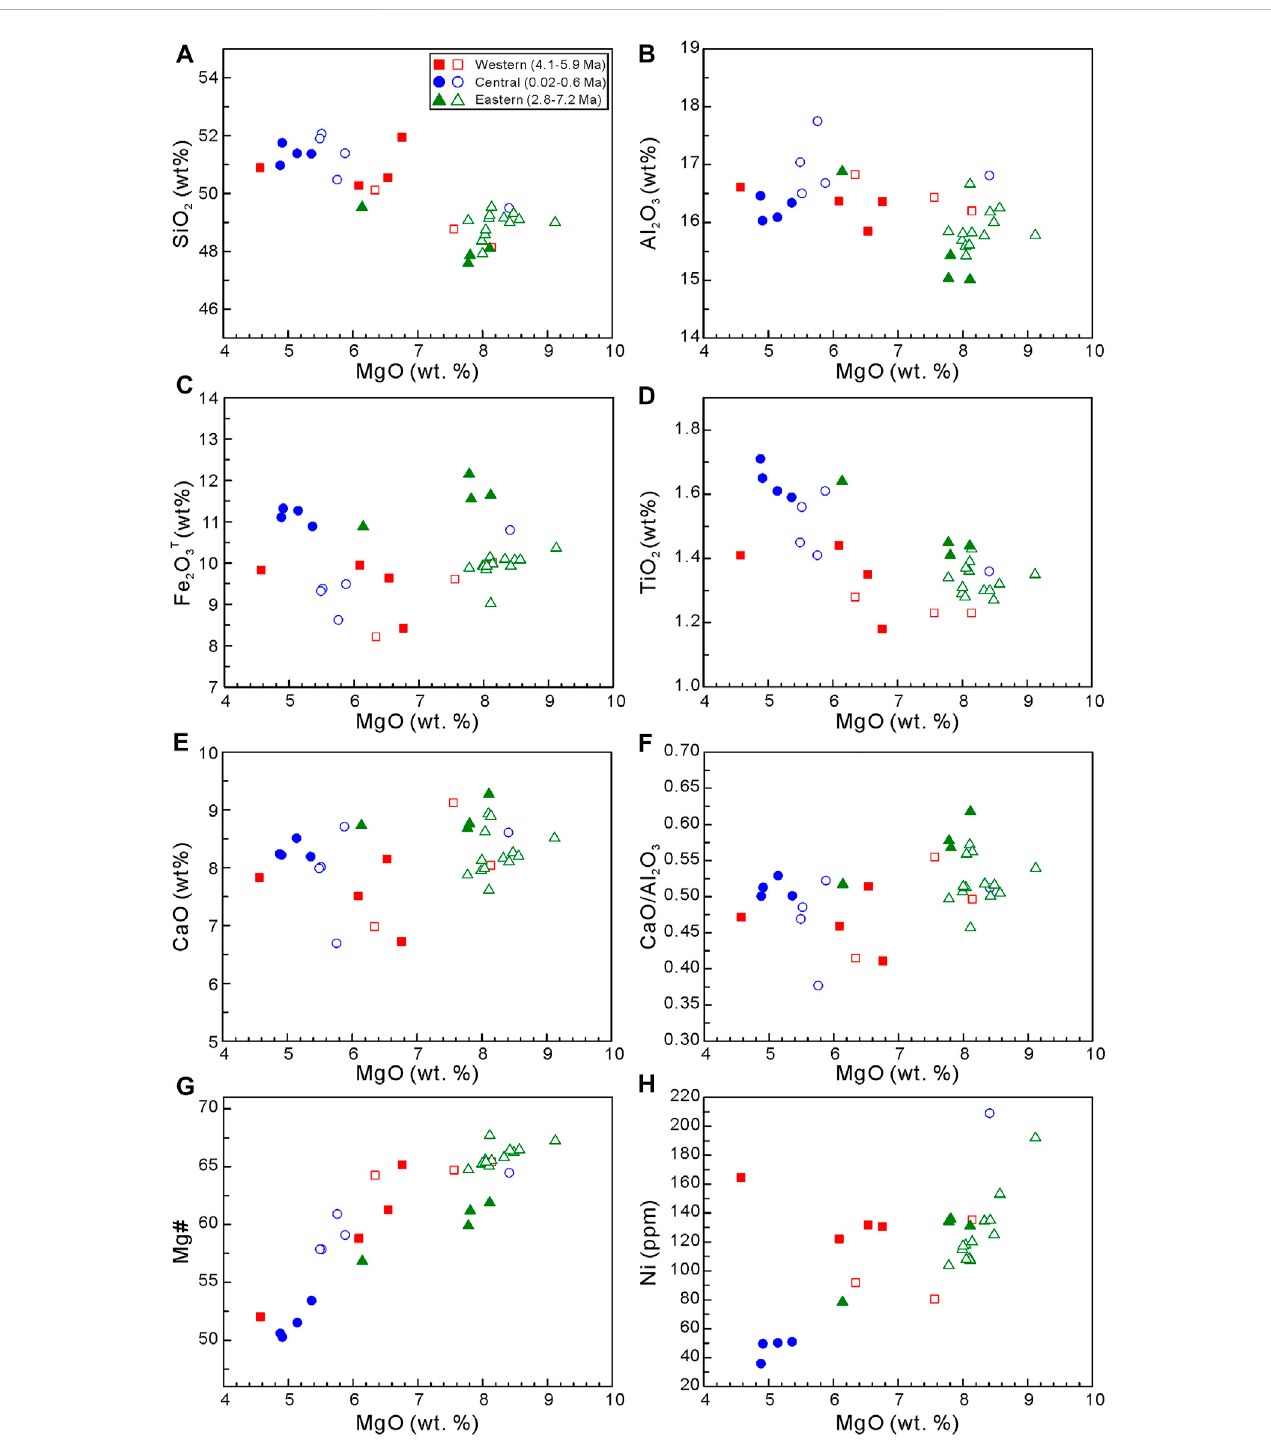
Table S3 in the Supplementary Information (S1). Previous